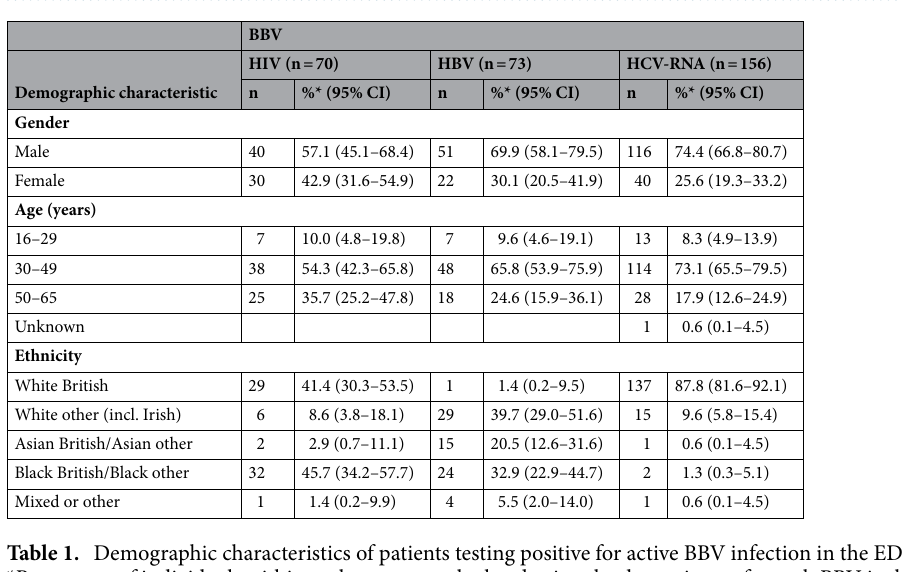
Figure 1. Flow of patients through the BBV testing pathway within the ED testing programme.